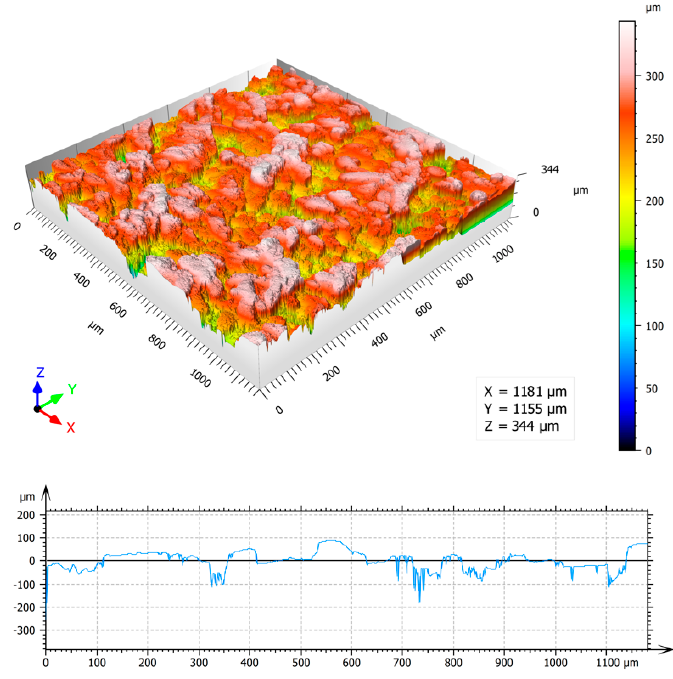
Figure 7. The area roughness measurements–3D map and profile of surface S6: Sa = 33.1 µm, Sz = 344 µm, Sp = 85 µm, Sv = 259 µm, Sq = 41.5 µm.